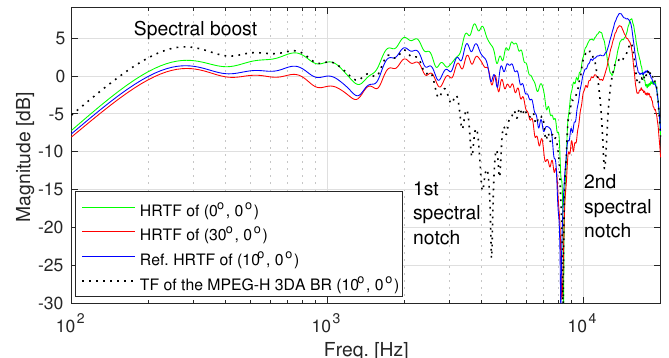
( k ) | (dotted line) for a virtual source at + 10 ◦ to the right from the frontal direction, Figure 3. | H L BR rendered using a pair of loudspeakers at 30 ◦ and 0 ◦ ( p = 2). Left ear is located at the azimuth of 90 ◦